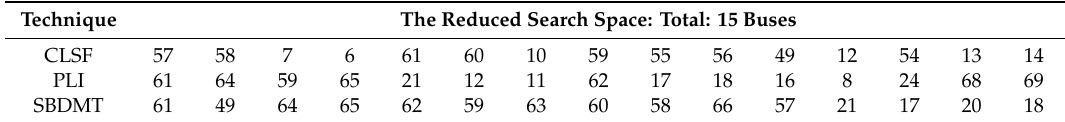
Table 6. The reduced search space by SBDMT comparing to combined loss sensitivity factor (CLSF) and power loss index (PLI) for the 69-bus